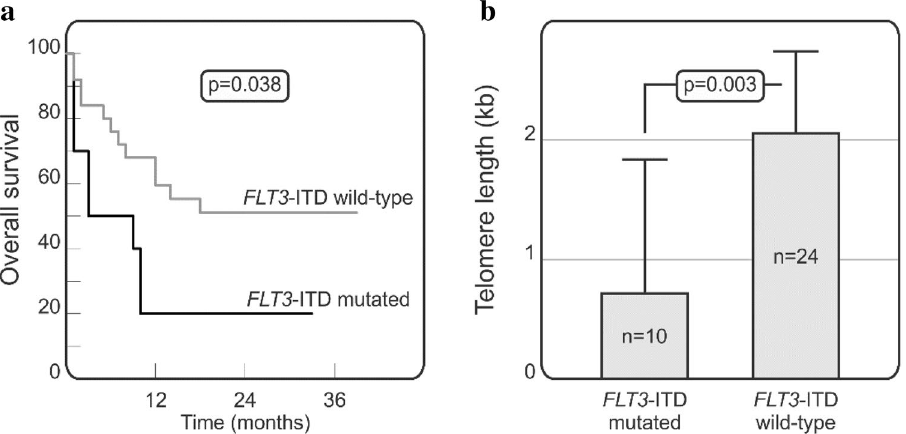
Figure 3. The effect of the presence of FLT3 -ITD mutation on telomere length and survival in patients below 61 years of age. Kaplan-Meier curves for overall survival in patients stratified with respect to the presence of FLT3 -ITD mutation. Gehan-Breslow-Wilcoxon test was used for statistical analysis ( a ). Differences in median telomere length in AML patients having or lacking FLT3 -ITD mutation assessed by Mann-Whitney U test ( b ).